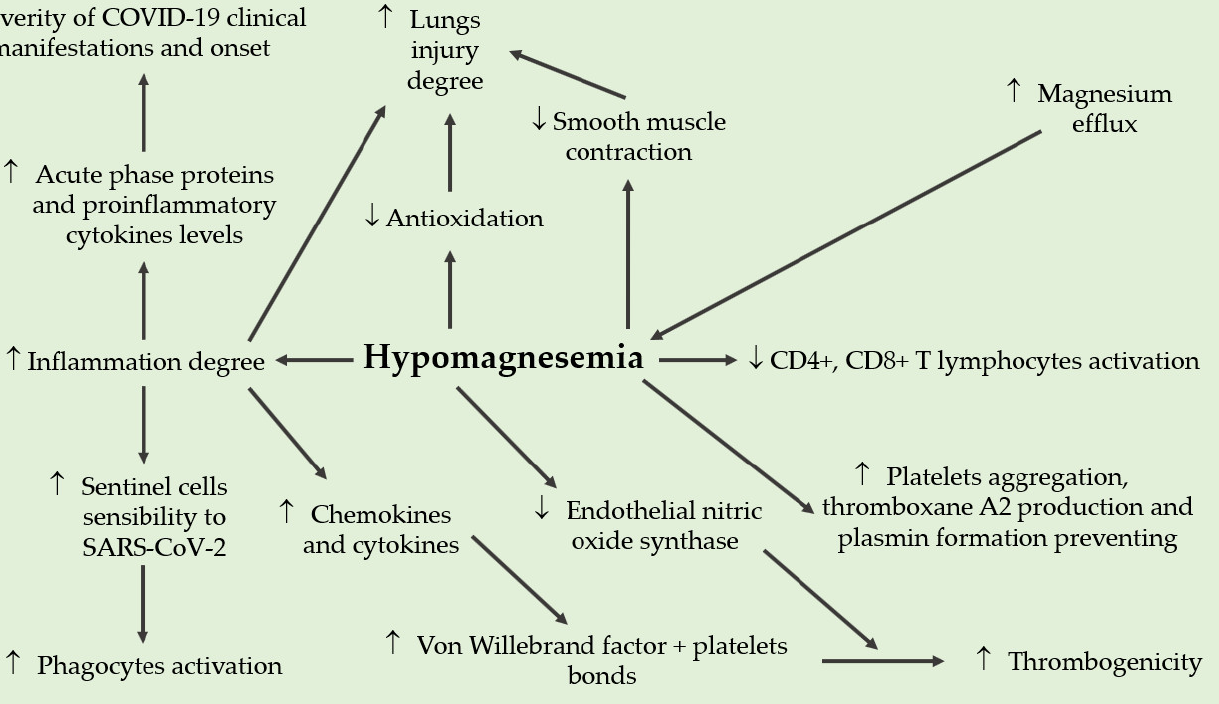
Figure 1. Pathophysiological role of magnesium deficiency in infection with